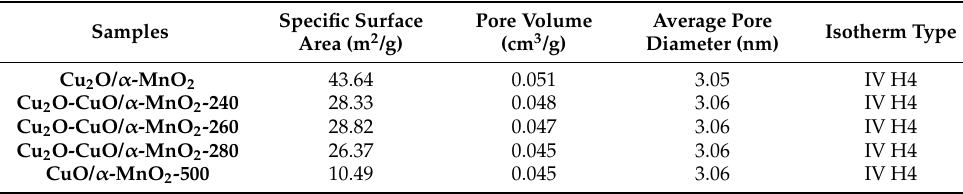
Table 2. Structural properties of the as-prepared catalysts.